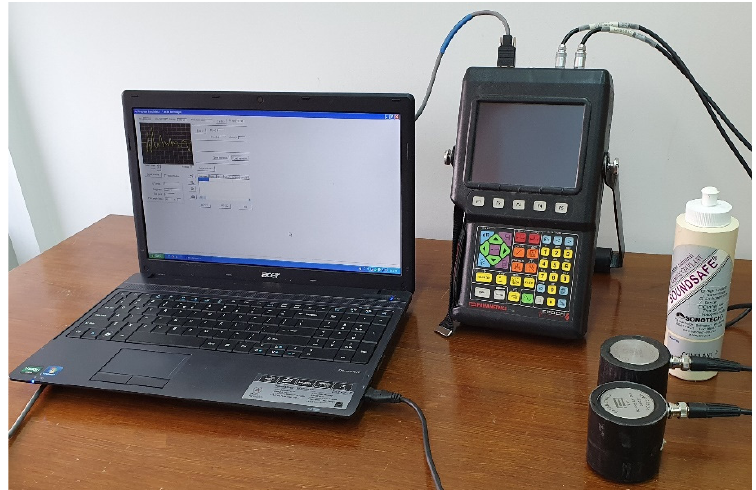
Figure 3. The ultrasonic experimental setup used in the study–ultrasonic defectoscope Epoch4, piezoelectric transducers of 100 kHz central frequency and coupling gel (Panametrics NDT-Olympus NDT, Shinjuku, Tokyo, Japan).